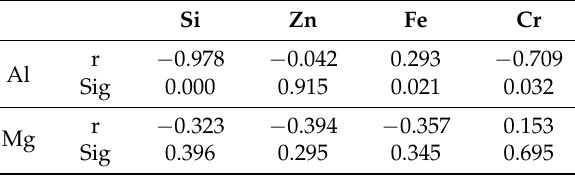
Figure 4. The crystal structure of spinel. Table 3. Correlation analysis among the chemical components of spinel.